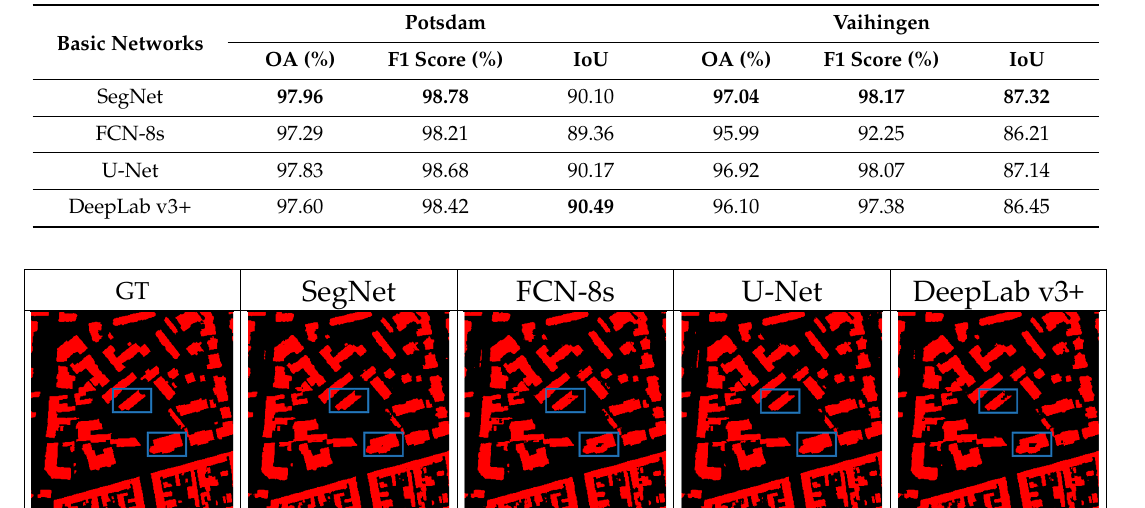
Table 7. Quantitative results of SegNet, FCN-8s, U-Net, and DeepLab v3 + based MAFNet.